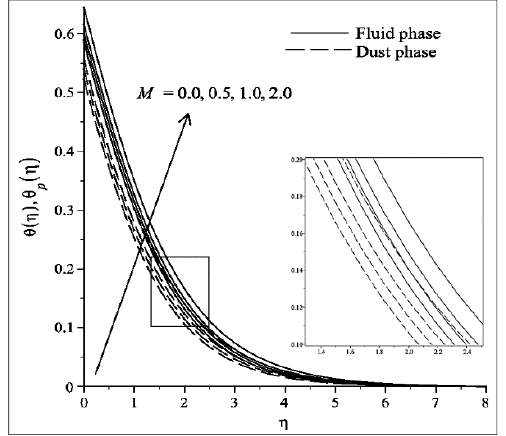
Figure 3. Profile on temperature for various M .